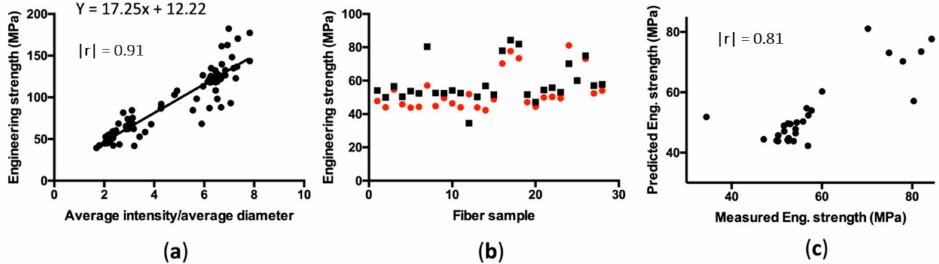
Figure 4. The process for the prediction of recombinant spider silk fiber tensile strength values. ( a ) Curve fitting to a scatter plot of normalized birefringence intensity plotted against measured engineering strength. ( b ) The predicted engineering strength of the individual fibers (red solid circles) based on the equation derived from Figure 4a and the corresponding measured engineering strength (black solid boxes). ( c ) Predicted engineering strength plotted against measured engineering strength. Insets: equation used for prediction and correlation coefficient